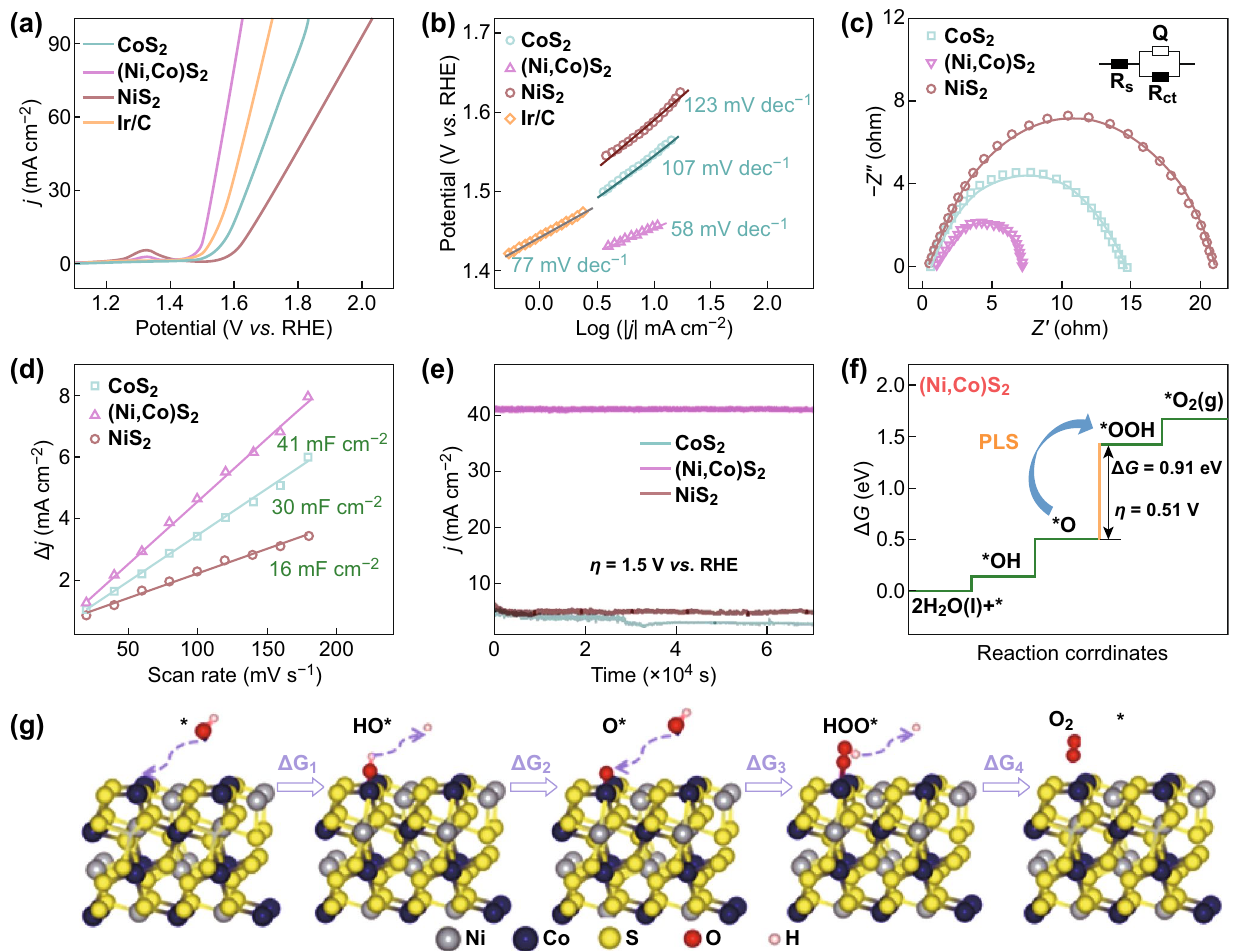
Fig. 3 a Polarization curves of (Ni,Co)S 2 , NiS 2 , CoS 2 , and Ir/C (20% Ir) at 5 mV s −1 in 0.1 M KOH. b Tafel slopes obtained from the corre- sponding polarization curves. c EIS of (Ni,Co)S 2 , NiS 2 , and CoS 2 . The inset is an analogue circuit diagram. d C dl obtained by cyclic voltamme- try at different scan rates. e I – t curves at 1.5 V versus RHE for 7 × 10 4 s. f Schematic of Gibbs free energy changes in the four elementary steps during OER on (100) surface of (Ni,Co)S 2 . g Proposed 4-step OER path presented using the model of (100) surface of (Ni,Co)S